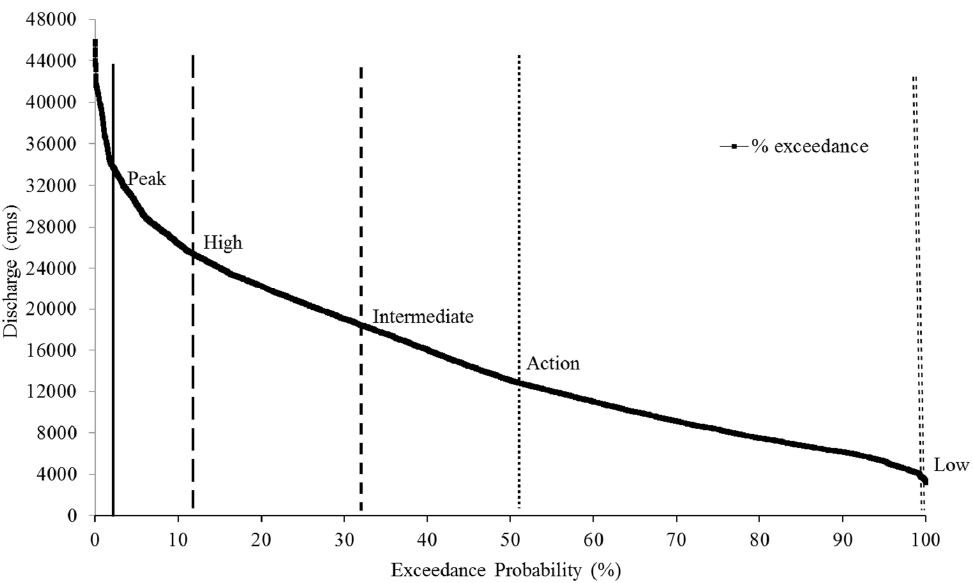
Figure 7. Flow duration curve for Tarbert Landing of the LmMR during 1973–2013. The vertical dash lines represent the exceedance probabilities for five river stages as defined by NOAA, i.e. , Peak, High, Intermediate, Action and Low Flow Stages.